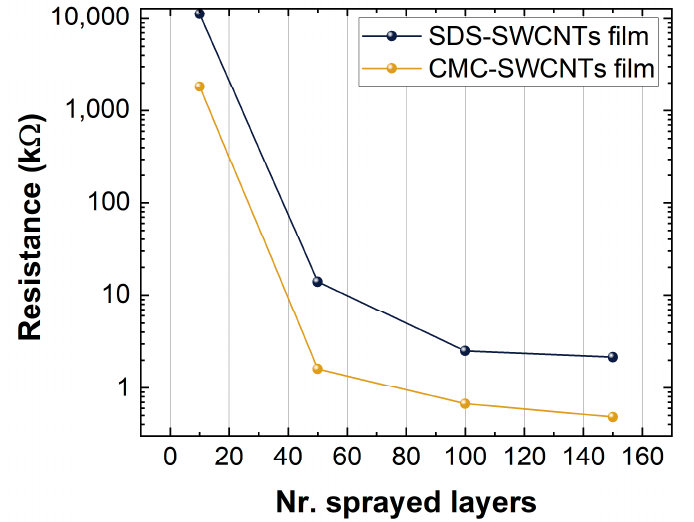
Figure 7. Resistance values versus numbers of layers of the sprayed SDS-SWCNT film and the CMC-SWCNT film.